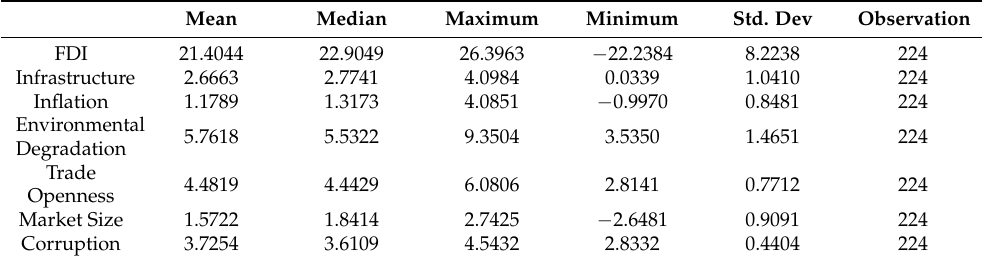
Table 2. Descriptive Statistics Results.